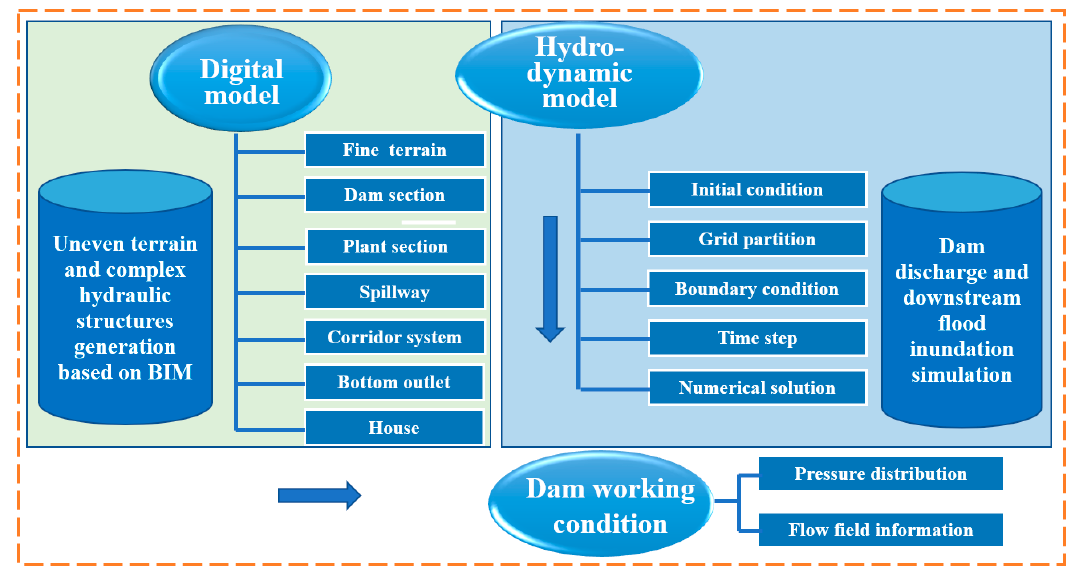
Figure 2. The physics-based dam discharge and flood routing simulation framework.